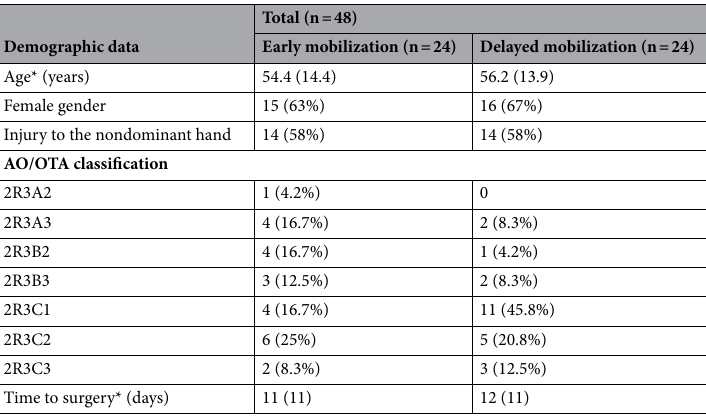
Table 1. Demographic data. *Data were presented as median (interquartile